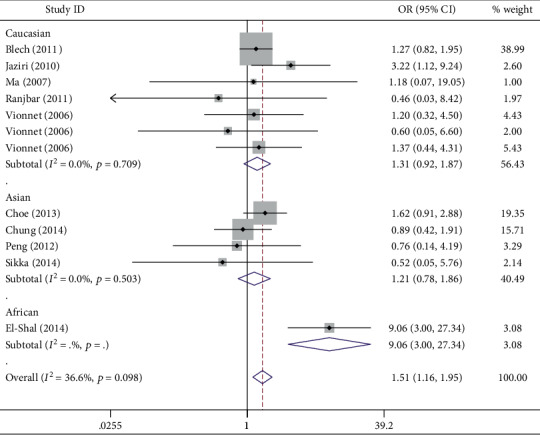
Forest plot for the association between the ADIPOQ rs2241766 polymorphism and DKD risk in the GG vs. TT comparison. The squares and horizontal lines correspond to the study-specific OR and 95% CI. The area of the squares reflects the weight (inverse of the variance). The diamond represents the summary OR and 95% CI.